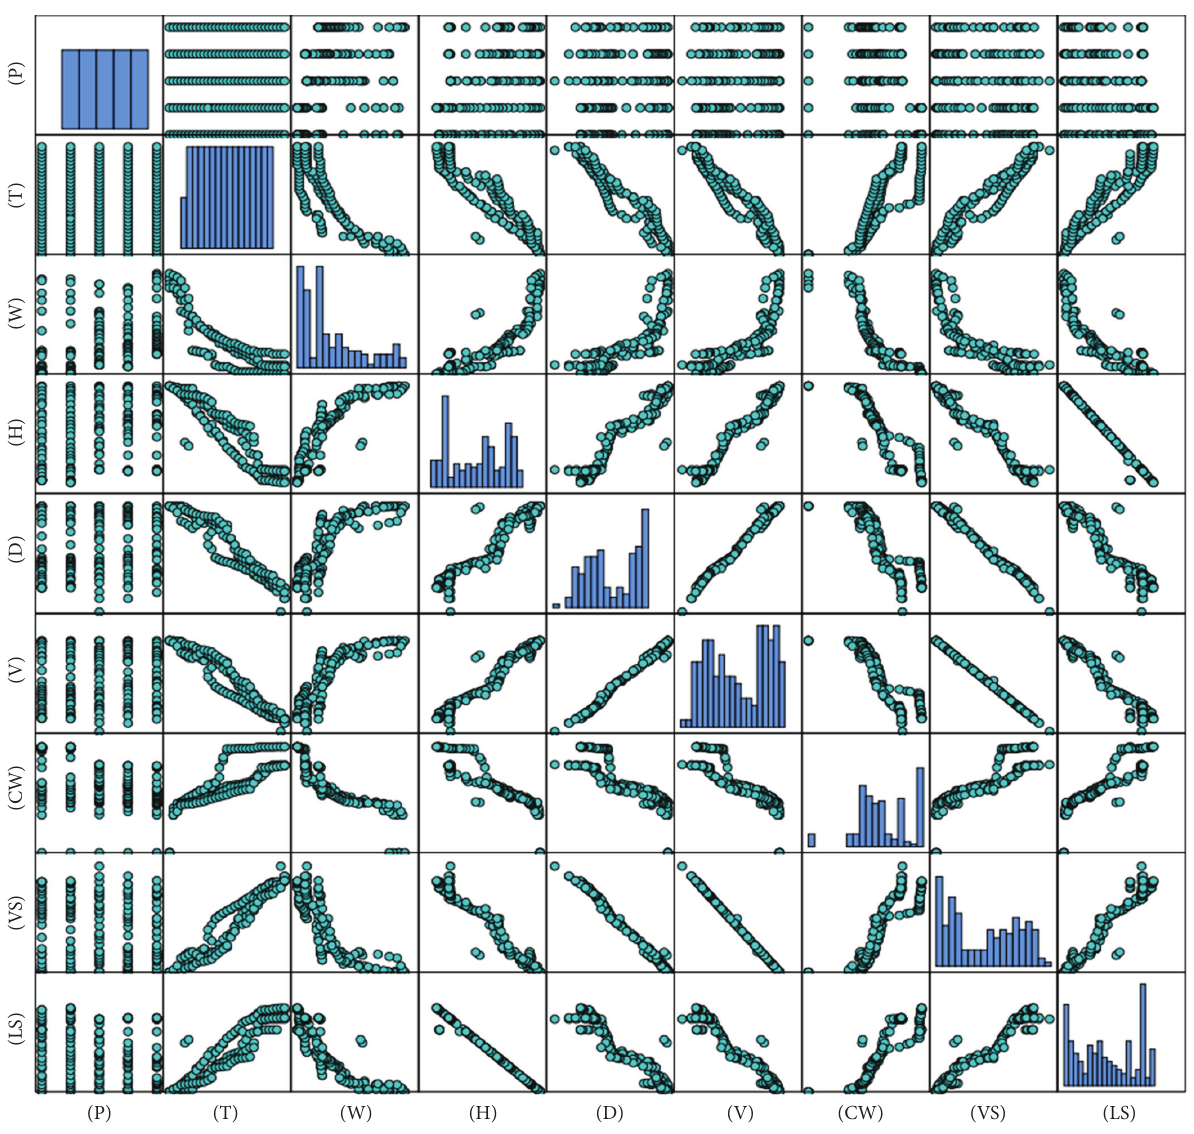
Figure 8: Pearson’s schematic linear correlation regression of input and output data.